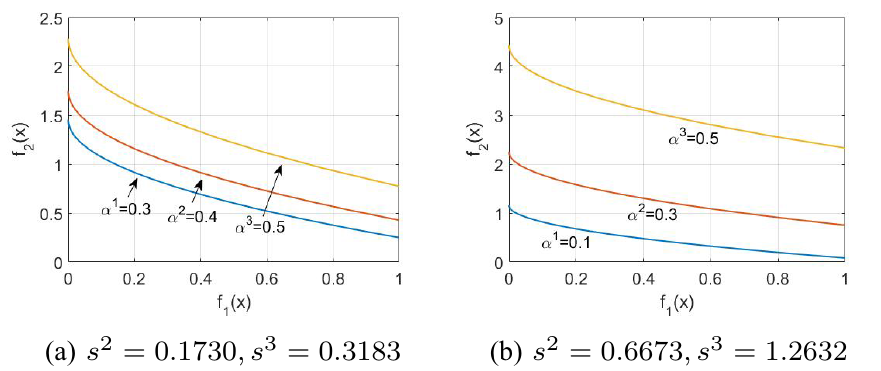
Fig. 1 The true Pareto fronts of FDA3 under three adjacent